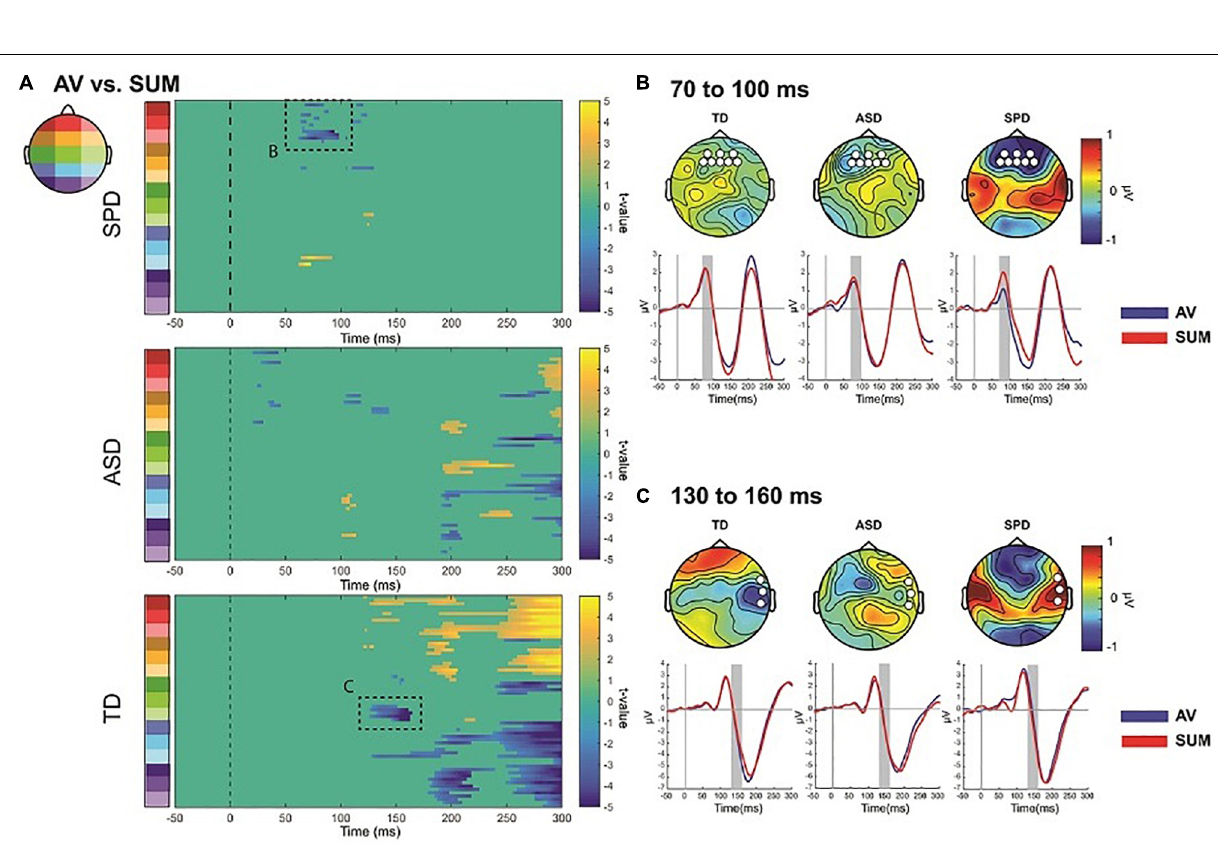
Frontiers in Integrative Neuroscience |